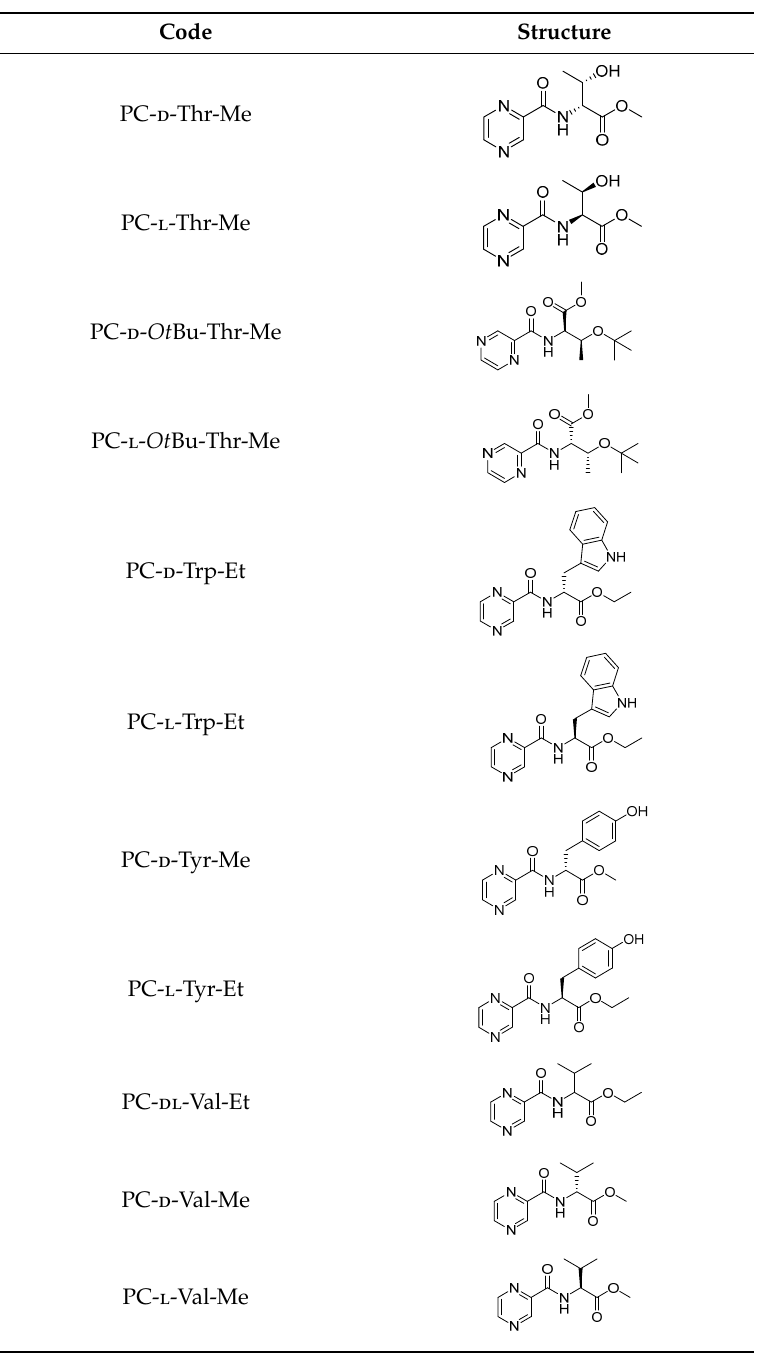
(cid:48) Procedure 4: The use of standard coupling reagents as 1,1 -carbonyldiimidazole (CDI) in anhydrous tetrahydrofurane (THF) with aa showed good results, although in some cases starting pyrazinoic acid was still detected by TLC as a small impurity di ffi cult to separate. Procedure 5: At last, general procedure, as described in Section 3.1.1. (and shown in Figure 2), was achieved by adjusting Procedure 4. The method employs esters of aa instead of aa with the free carboxylic group. The increased solubility of the reactants and products in used organic solvents (THF) greatly simplified the syntheses and subsequent purifications. The products were created in good yields (positively related to their lipophilicity) and without